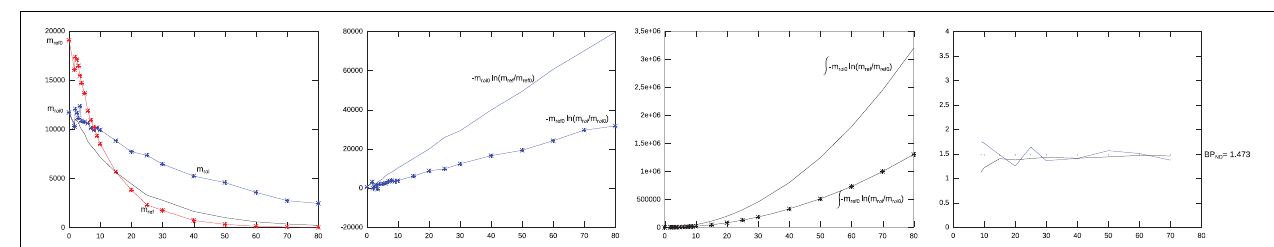
FIGURE 1 | Behavior of the parts of the WARM method. The first leftmost panel shows two initial simulated mono-exponential washout curves, a reference curve ( k ND 2 = 0 . 92) in red, and a binding curve ( k 2 a = 0 . 98) in blue. The black curve shows the flow normalized version of the reference curve normalized to the ROI curve, with 20% Gaussian noise added. The second panel shows the denominators and nominators from Equation (40) as function of time, i.e., the fraction between these